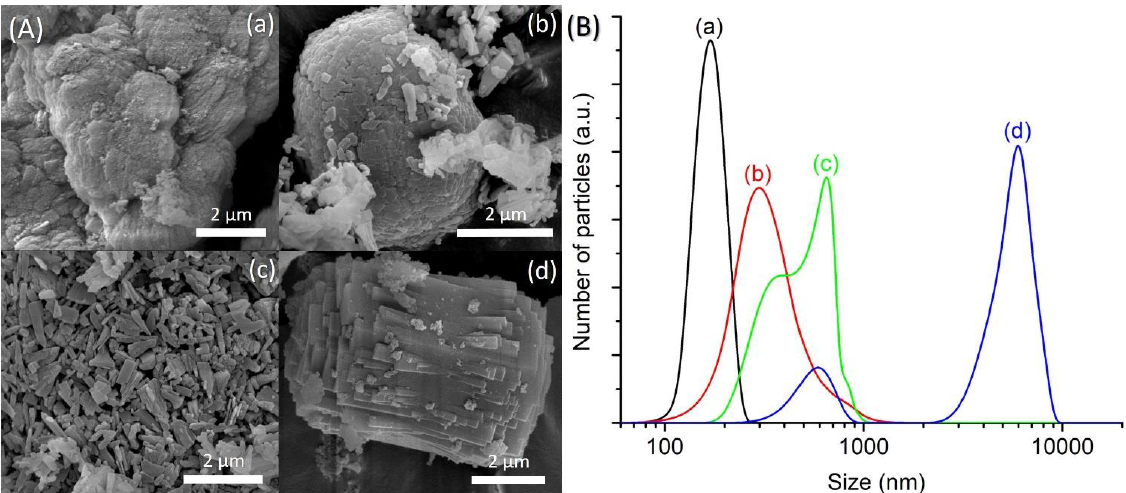
Figure 10. ( A ) FESEM images and ( B ) particle size distributions of ( a ) SH15 ( z = 0), ( b ) SH16 ( z = 0.23), ( c ) SH4 ( z = 0.47) and ( d ) SH17 ( y = 0.70) prepared with a molar composition of 1Al 2 O 3 :2.5P 2 O 5 :2.5[bzmIm] 2 O:180H 2 O: z SiO 2 heated at 150 °C for 10 h.